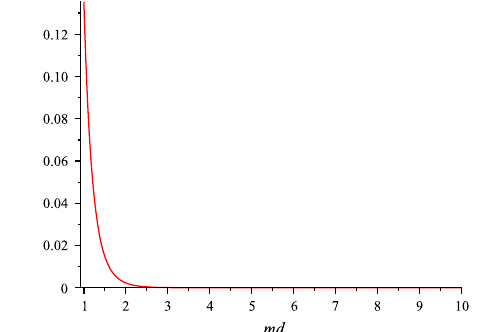
Fig. 4 Graphic for the modulus of the force (51) multiplied by α(cid:9)μ | 2 m 3 | − 1 as a function of md . Expression (51) is valid just j B m for large values of